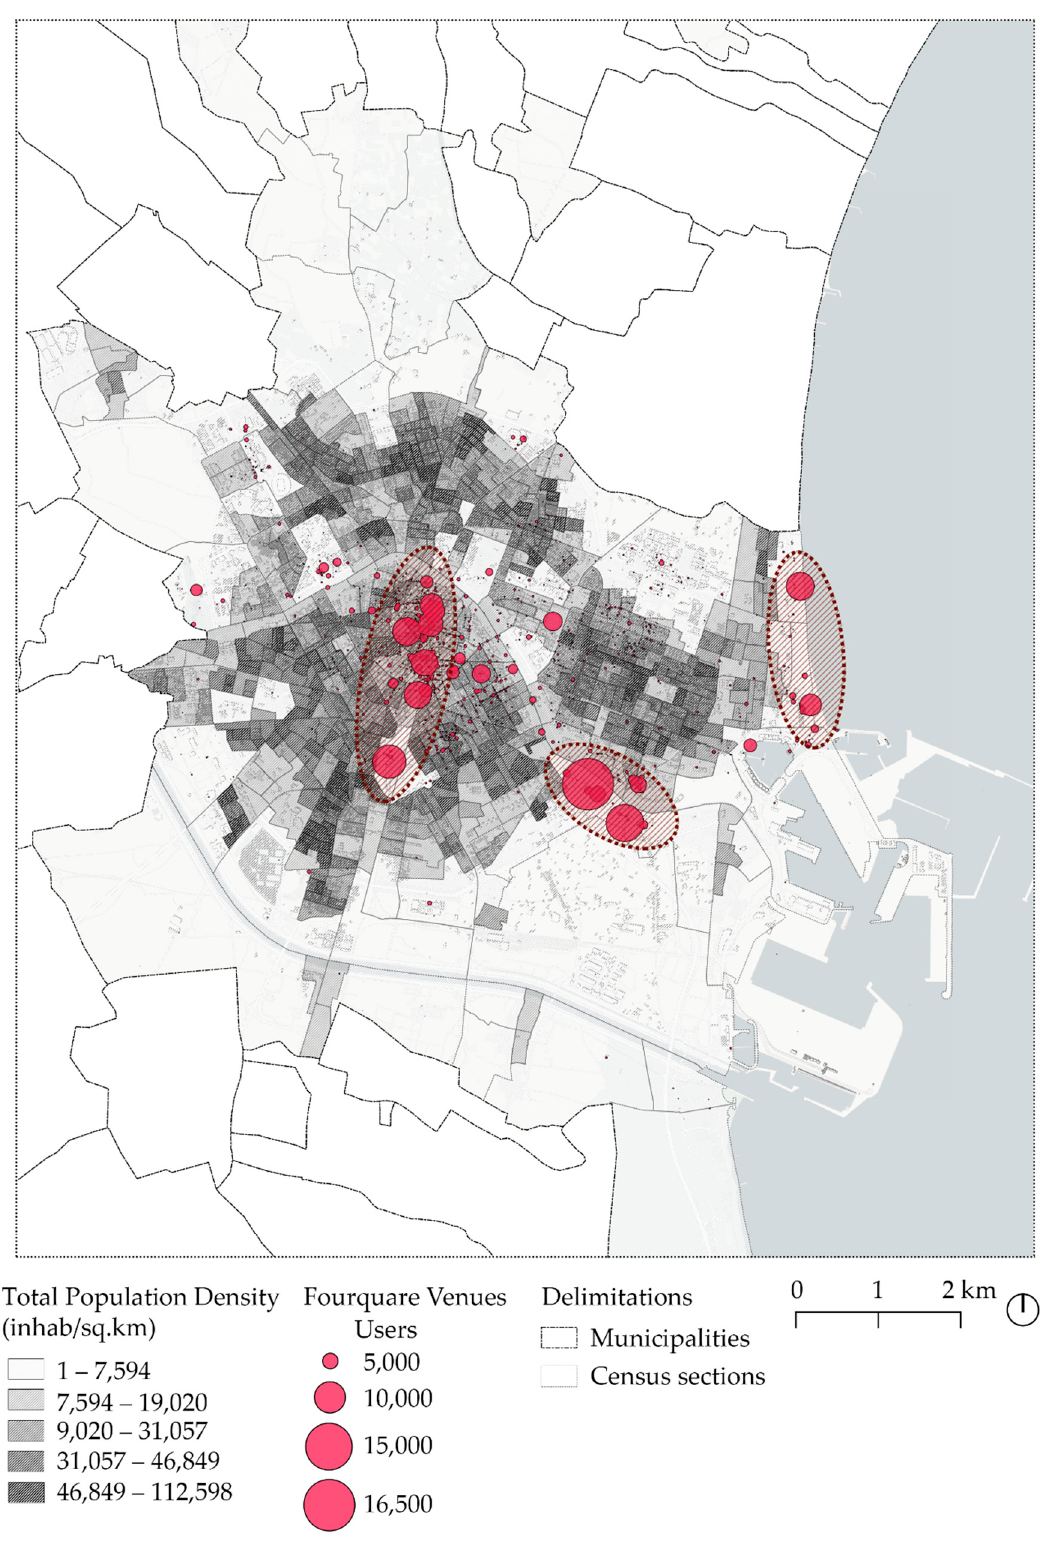
Figure 10. Foursquare’s top10 venues cluster and population density per census section.